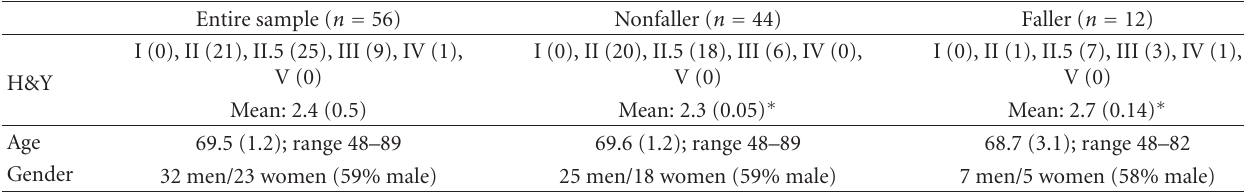
Table 1: Participant demographics.